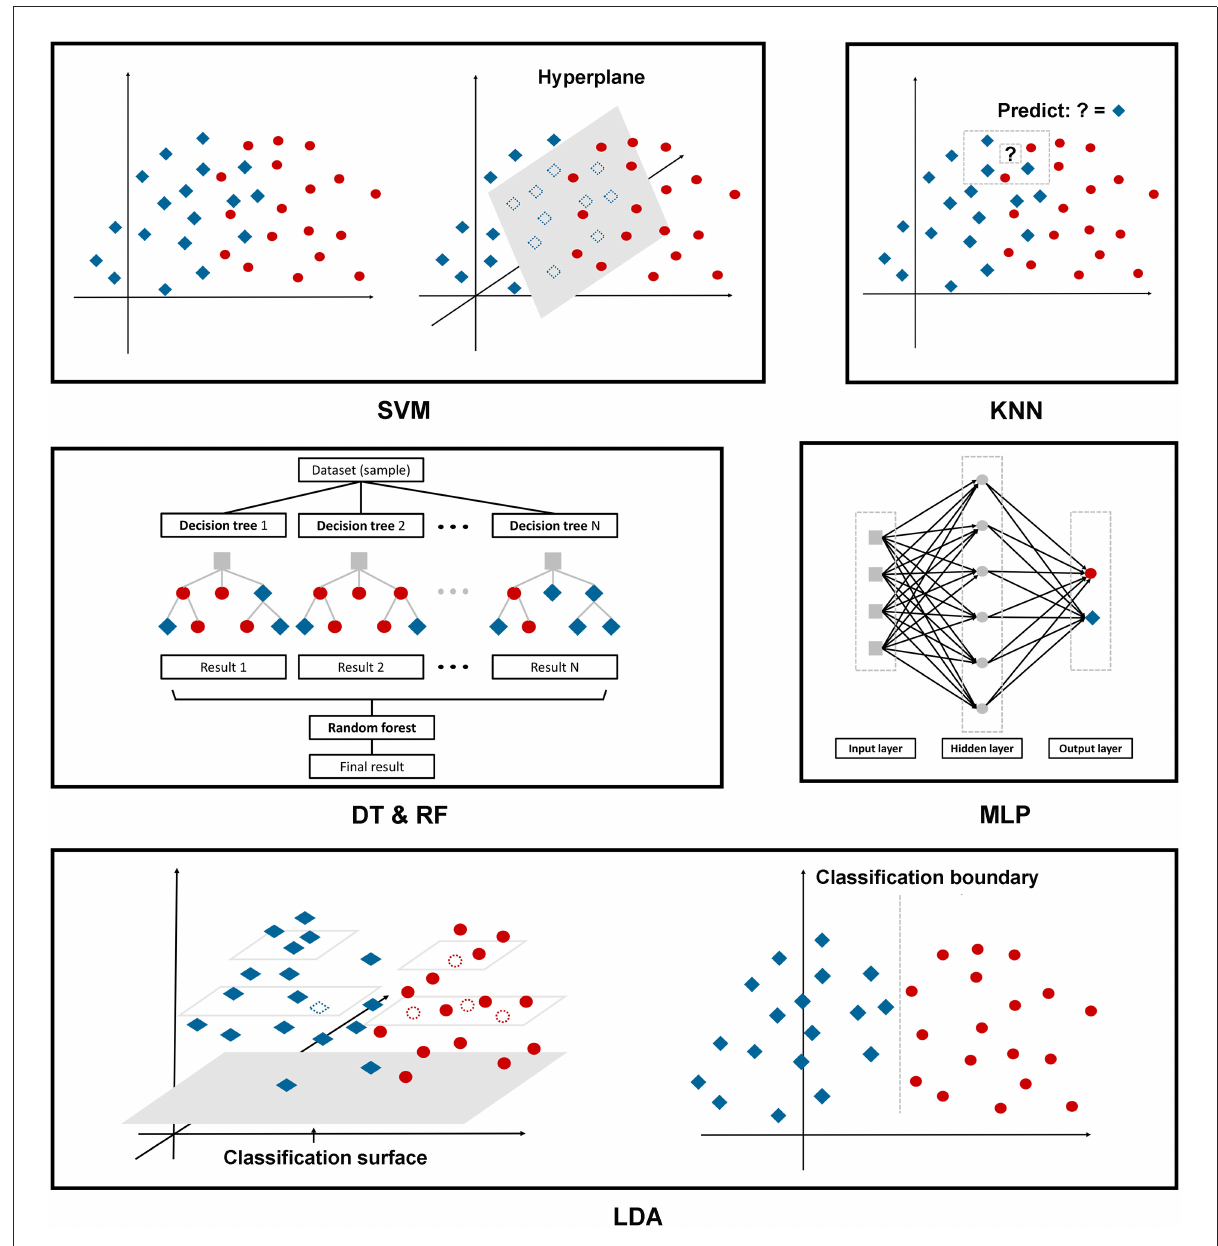
FIGURE2 The illustration of the machine learning algorithms applied in this research.